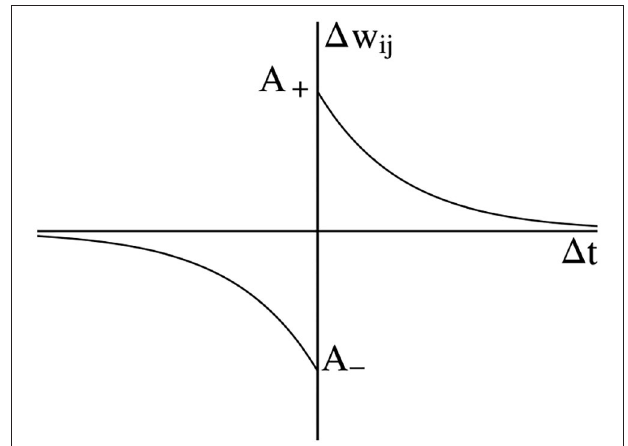
FIGURE 1 | Standard Spike-Timing-dependent Plasticity (STDP)